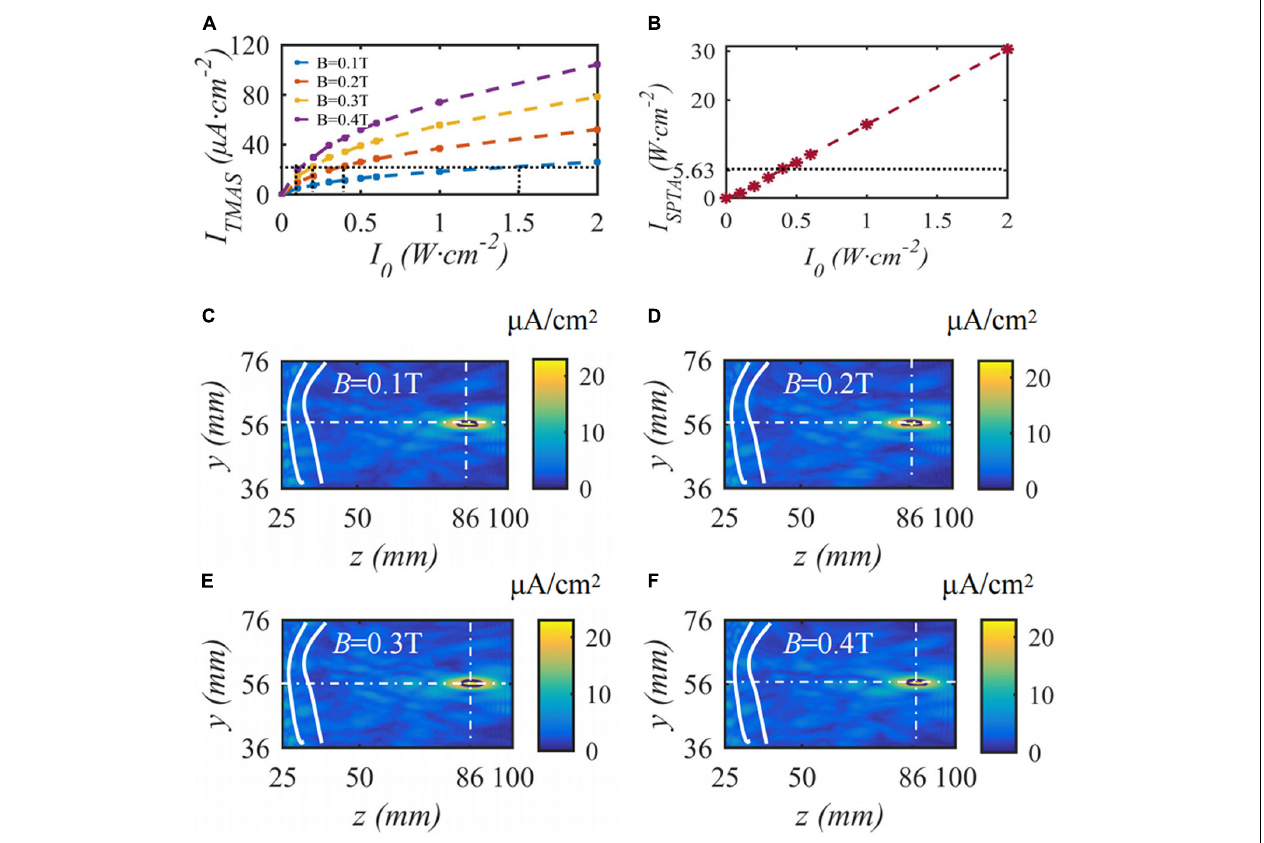
FIGURE 11 | The distribution of induced current density under different static magnetic field strengths, (A) is the change curve of induced current density with the input sound intensity, (B) is the spatial peak time-averaged sound intensity variation curve with output sound intensity, (C–F) are the distribution of induced current density ( J = 22.3 µ A · cm - 2 , t = 10